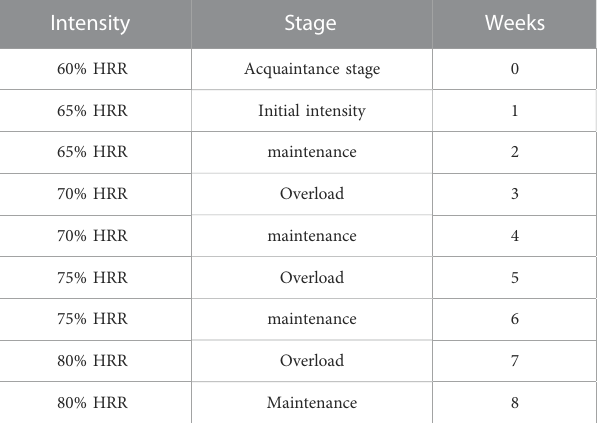
TABLE 1 The mode of intensity overload in the MCT group. (HRR: heart rate